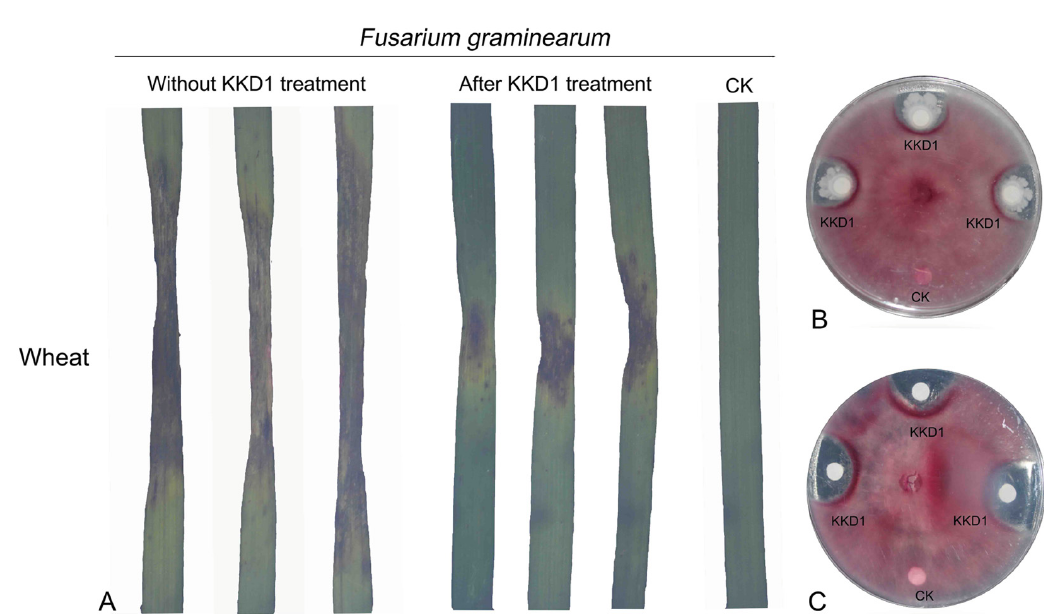
Figure 8. Antagonistic action of B. halotolerans KKD1 versus F. graminearum . ( A ) In vitro response of wheat leaves after infection with F. graminearum . Representative lesion lengths in wheat leaves following inoculation with control F. graminearum and F. graminearum after cultivation with strain KKD1. ( B ) Inhibition zones of F. graminearum caused by the KKD1 colonies. ( C ) Inhibition zones of F. graminearum caused by the lipopeptide extracts of KKD1.